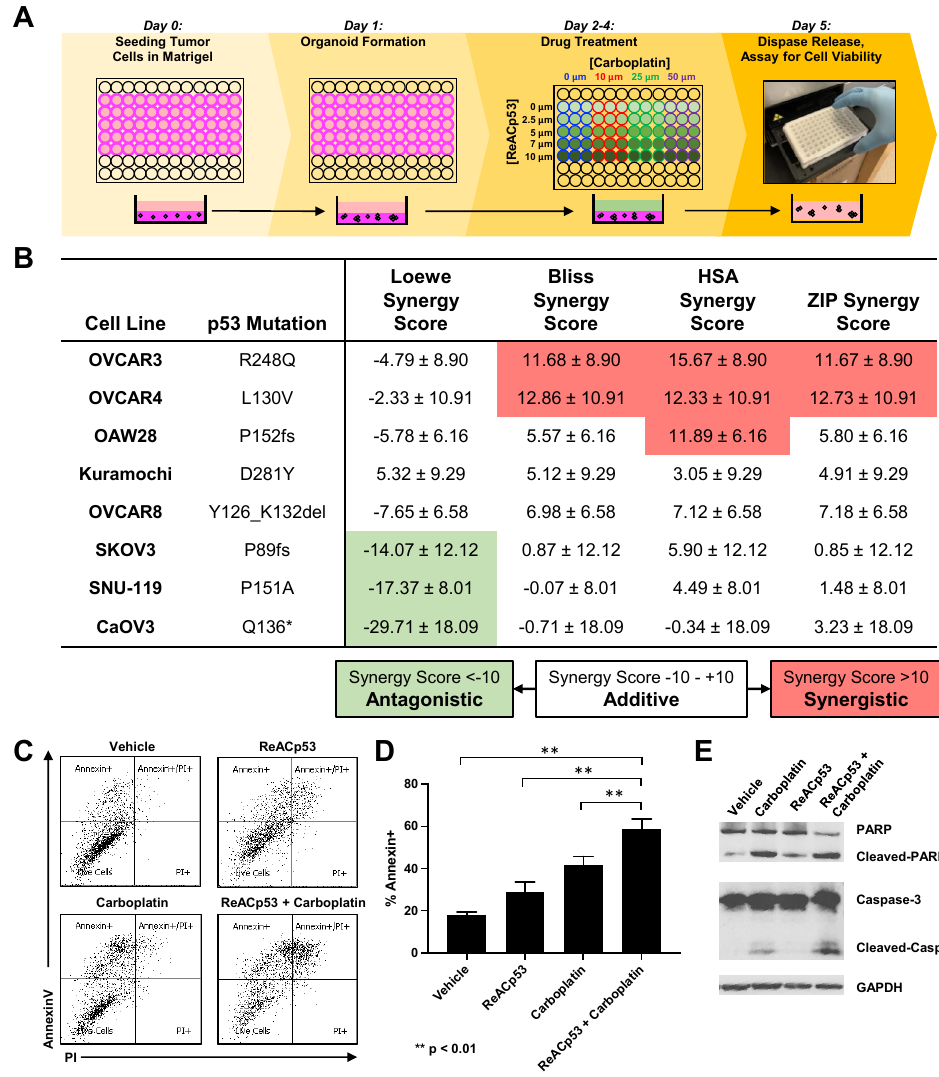
Figure 3. Synergistic activity of ReACp53 and carboplatin combination observed in a subset of human ovarian cancer cell lines in vitro. ( A ) Schema of the in vitro 3D mini-ring organoid drug assay. Drug interaction studies were performed across a range of ReACp53 (0–10 µ M) and carboplatin (0–50 µ M) concentrations. ( B ) Eight independent ovarian cancer cell lines annotated in the Cancer Cell Line Encyclopedia (CCLE) were tested using the 3D mini-ring organoid drug assay, and potential synergy for the ReACp53 and carboplatin combination was calculated. Data shown were calculated using SynergyFinder 2.0 to measure synergy score ± 95% confidence interval. Results were averaged from five independent experiments plated by two separate investigators. In this analysis, OVCAR3 and OVCAR4 cells exhibited synergy when treated with the ReACp53 and carboplatin combination for the majority of the synergy models assessed (Loewe, Bliss, HSA, and ZIP). The remaining cell lines (OAW28, Kuramochi, OVCAR8, SKOV3, SNU-119, and CaOV3) exhibited additive effects for ReACp53 and carboplatin combination for the majority of synergy models assessed. ( C ) OVCAR3 organoids were treated with vehicle, ReACp53 (4 µ M), carboplatin (50 µ M), or ReACp53 + carboplatin for 72 h with daily drug replenishment. Organoids were released from Matrigel and stained for annexin V and propidium iodide. Data from one experiment is shown. ( D ) Percentage of annexin V+ cells in each treatment group. Data represent the mean of three independent experiments. ** p < 0.01. ( E ) Representative Western blot for detection of PARP, caspase 3, and GAPDH loading